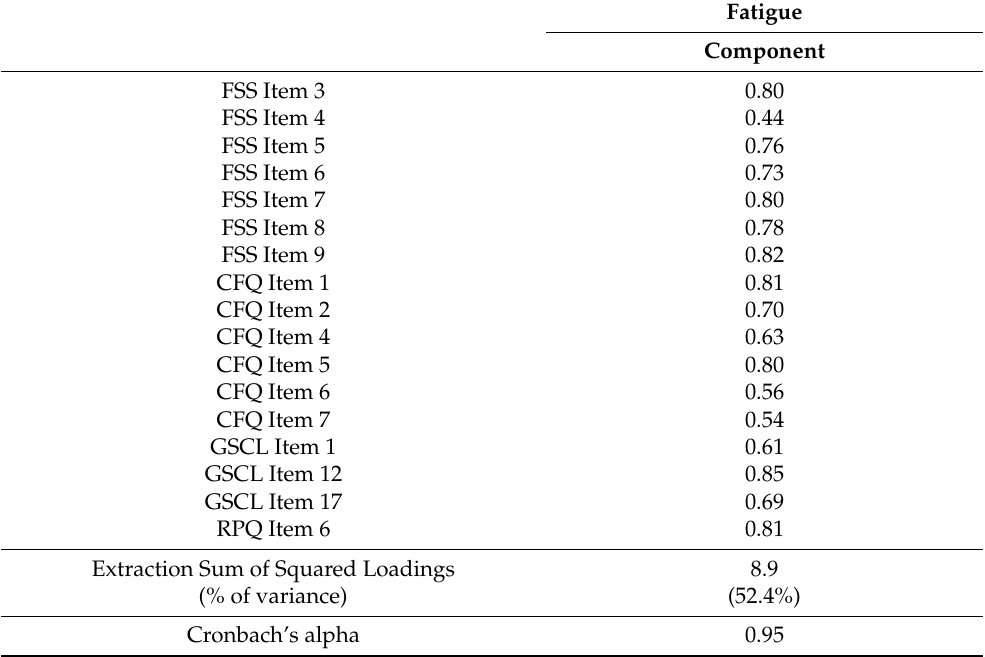
Table 1. Factor loadings of items from fatigue measures. All items load saliently on the component at significance level of p < 0.05, i.e., loadings above